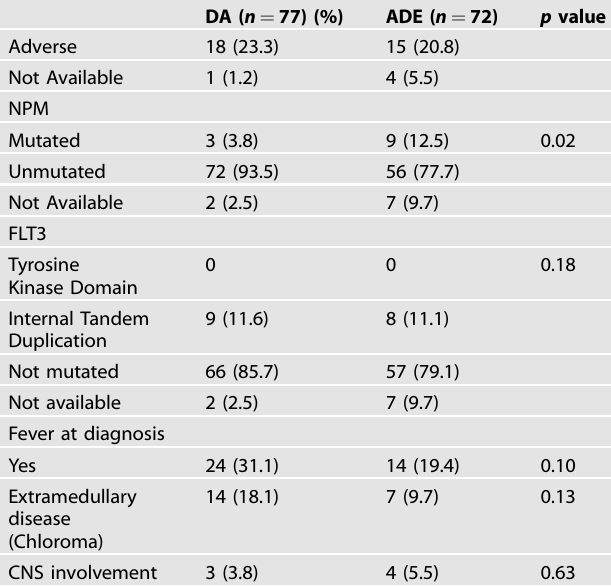
Table 2. Demographic, laboratory, and clinical characteristics of the patients in the